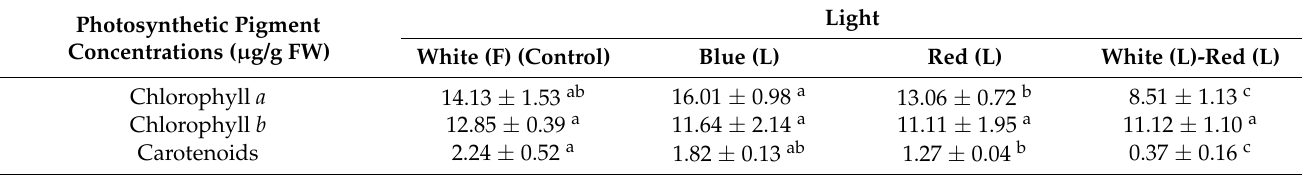
Table 1. Effect of different light conditions on photosynthetic pigment (chlorophyll a , b , carotenoids) concentrations in extracts of L. aestivum in vitro cultures. The results are means of 3 replicates ( n = 3) ± SD. Different letters indicate a significance difference at p < 0.05 according to ANOVA and Duncan’s test. F: fluorescence, L: LED light, FW: fresh weight.